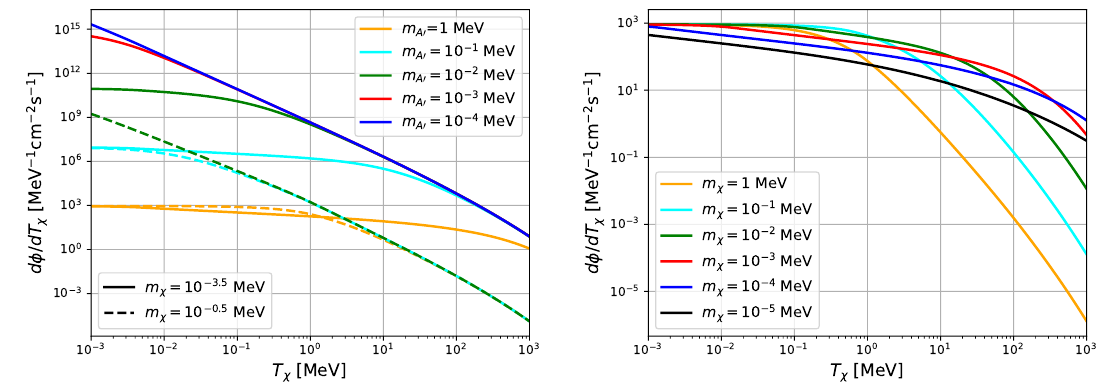
Figure 2 . Differential CRDM flux for different DM and dark photon masses. The masses are indicated by colors and line types as explained in the legends. In the right panel, m A 0 = 1 MeV is chosen. For both panels, we have chosen g 0 = 1 and (cid:15) = 1